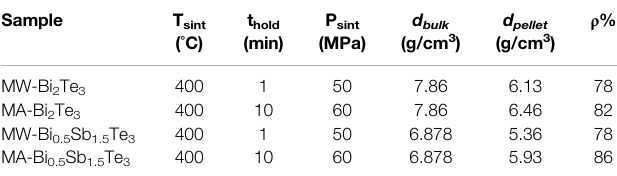
TABLE 1 | SPS parameters and transport properties for MW- and MA- Bi 2 − x Sb x Te 3 samples: sintering temperature (T sint ), holding time (t hold ), sintering pressure (P sint ), bulk density ( d bulk ), density of pellets by the Archimedes method ( d pellet ), and packing density ( ρ ) in percentage of theoretical